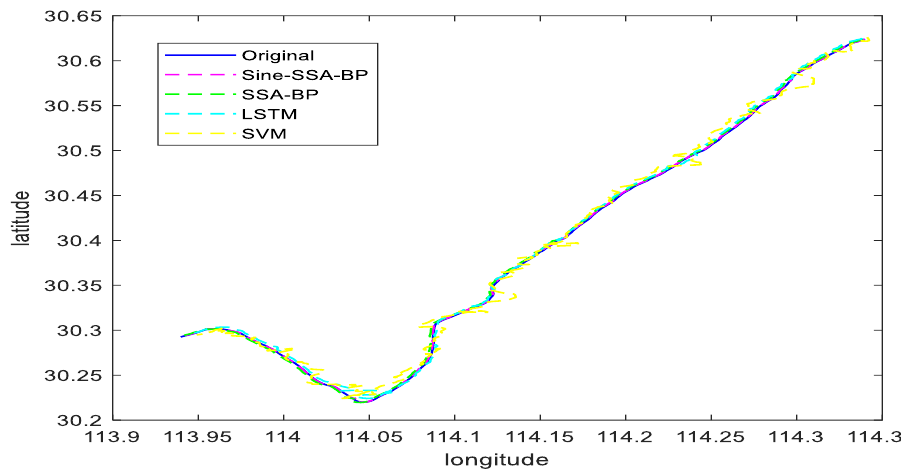
Figure 13 . Comparison of trajectory prediction of different models in Scenario 1. Figure 13. Comparison of trajectory prediction of different models in Scenario